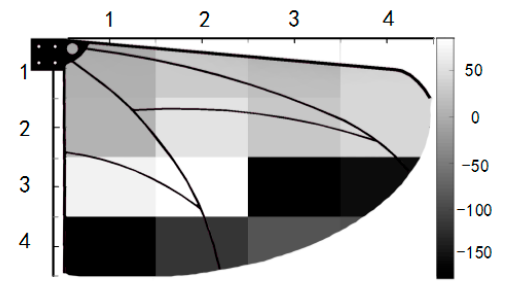
Figure 13. Real time voltage phase difference of divided area.